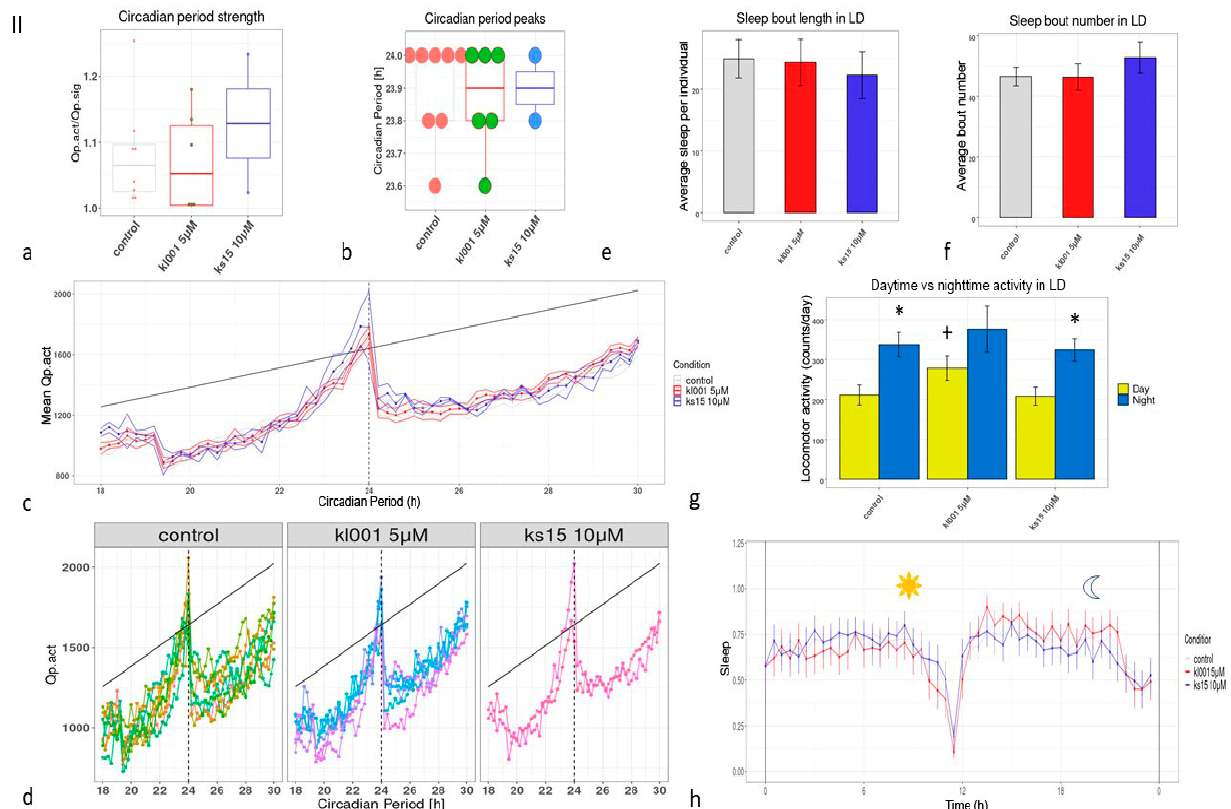
Figure 4. The parameters of male flies’ circadian rhythms, sleep/activity profile until the age of 34–41 days: ( a )—circadian period robustness; ( b )—circadian period peaks’ quantitative representation; ( c )—mean periodogram, ( d )—individual periodograms, ( e )—total sleep in LD, ( f )—sleep bout number in LD, *— p < 0.05, Mann-Whitney test; ( g )—comparative diagram daytime vs. nighttime activity in LD, *— p < 0.001 ANOVA with Tukey/Kramer procedure, also p < 0.01 with Scheffe’s procedure, for light and dark periods of the day, +—for light and light in different cohorts by treatment, ( h )—sleep profile for the differences in local distributions were measured with ANOVA for the control and KL001 groups. We observed only a total daytime activity elevation in the KL001 cohort of old age ( p < 0.01).